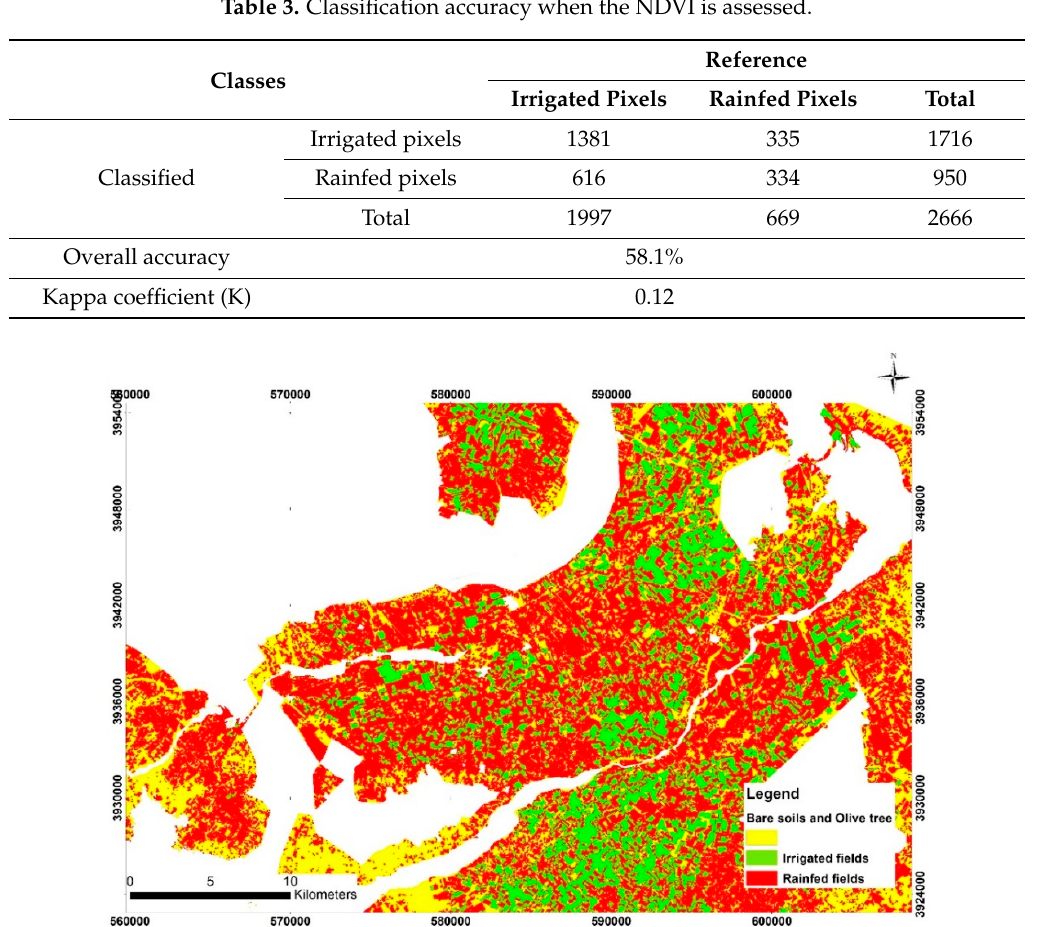
Figure 9. Classification of irrigated and rainfed areas using the NDVI parameter.